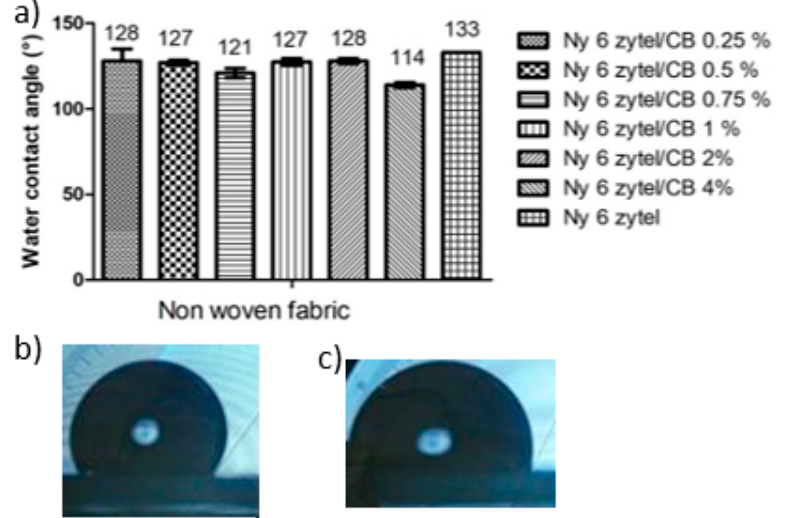
Figure 7. ( a ) Water contact angles of the samples Ny6 Zytel/CB to different con-centrations of carbon black and ( b ) images of water contact angles of the samples Ny6 Zytel pure ( b ) and Ny6 Zytel/CB 4% ( c